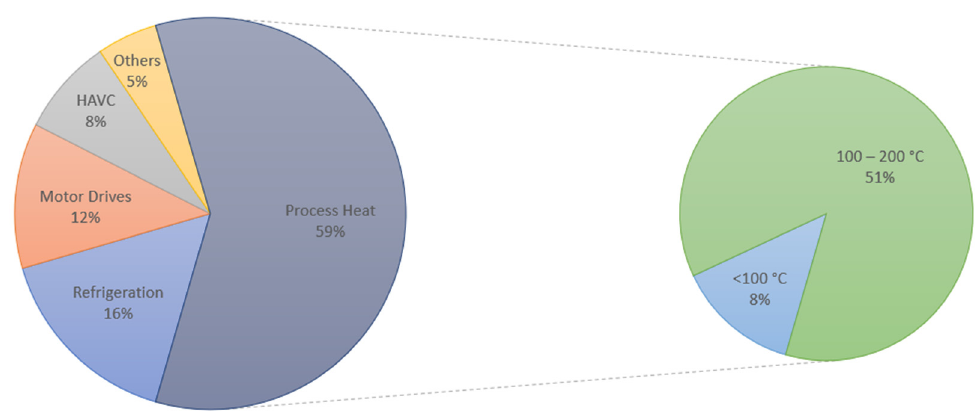
Figure 1. Typical energy consumption by end users in the food processing industry and temperature range, adapted from [12].